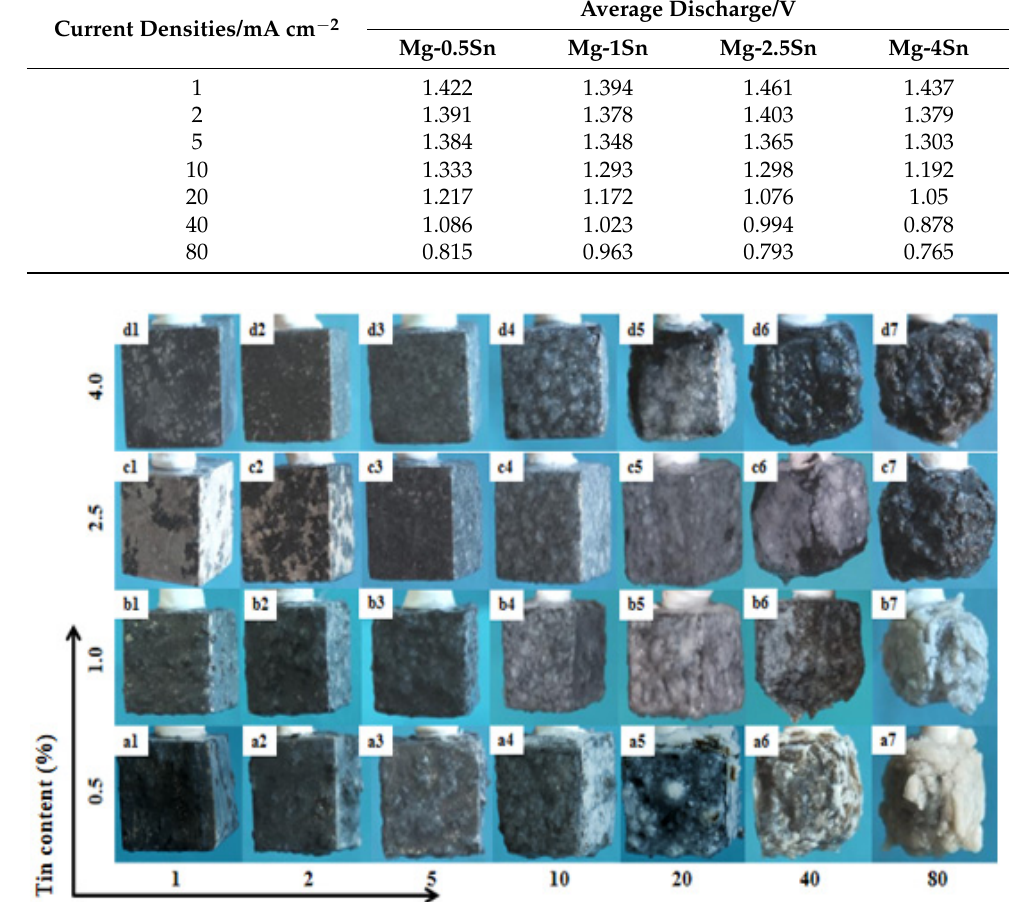
Table 5. Average discharge voltage of the studied anode at different current densities.